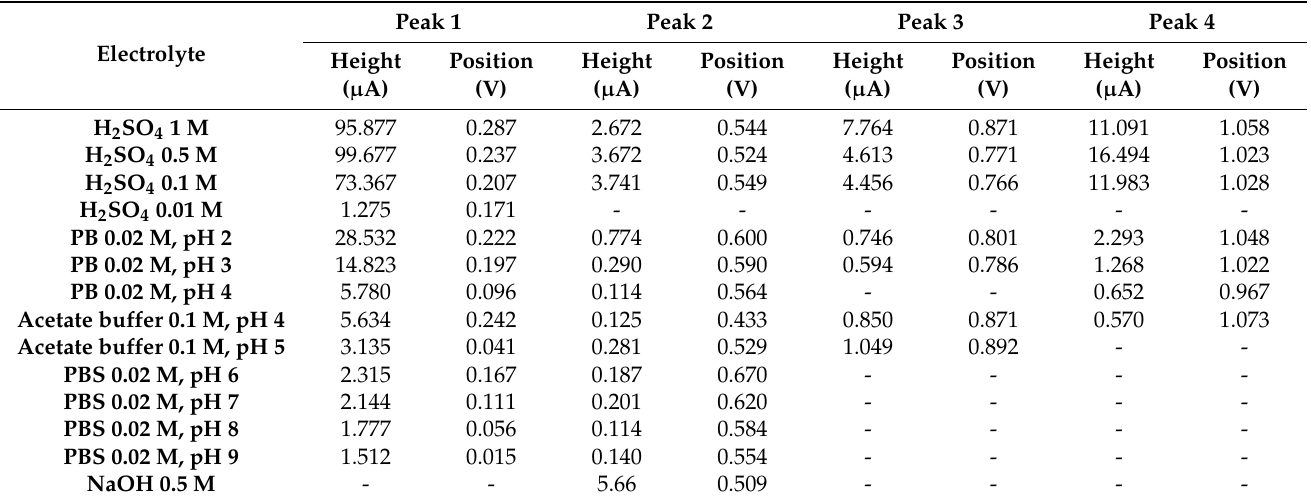
Table 2. The height/position of the peaks obtained by DPV on CNT-SPE of a 50 µ M PQS in different electrolytes.